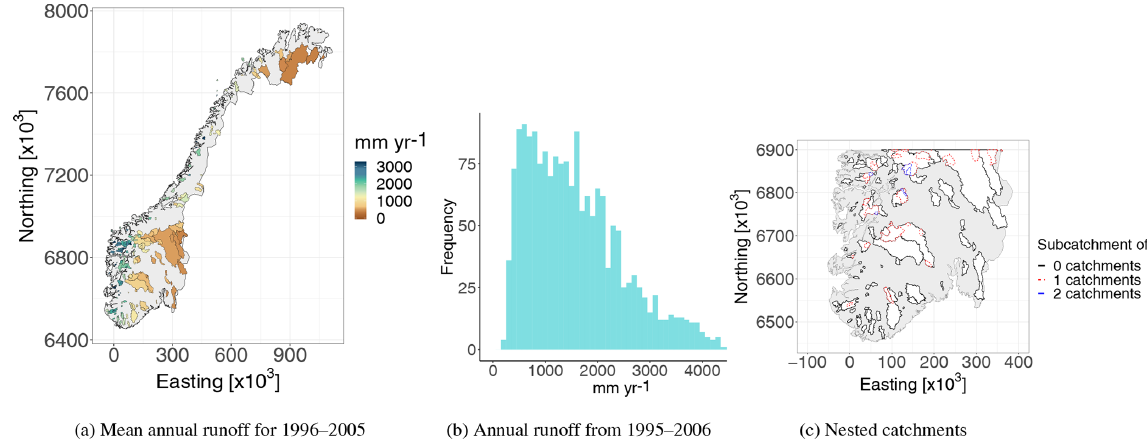
Figure 1. Mean annual runoff (1996–2005) from 180 fully gauged catchments in Norway (a) and annual runoff observations from all 180 catchments and years (b) . These data are used to evaluate the framework’s ability to fill in missing values for individual years. Thirty percent of the involved catchments are nested and most of these are located in southern Norway as visualized in (c) . In (c) , coloured catchments are subcatchments of at least one larger catchment, while the black catchments are not subcatchments of any larger catchments (but might contain one or two smaller catchments). In the visualization in (a) , subcatchments are plotted on top of larger catchments, and this is done throughout the article. The coordinate system used is EUREF89 – UTM33N (EPSG 25833). See Fig. 7 for a closer image of the observed mean annual runoff in southern Norway (1996–2005).